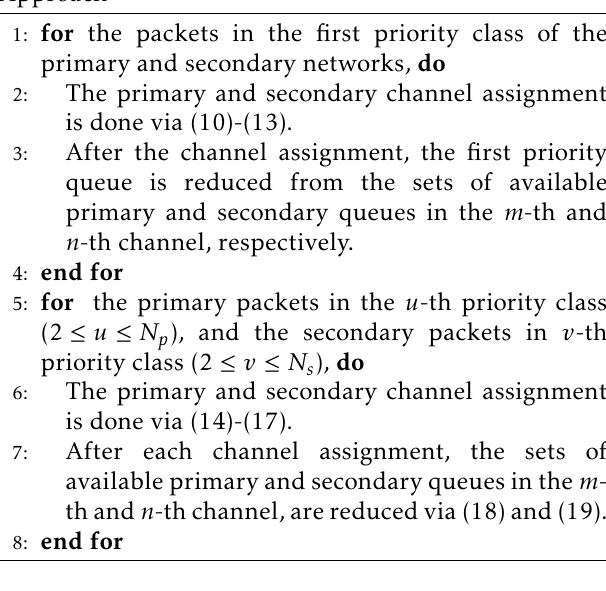
Algorithm 1 Context Aware Channel Assignment